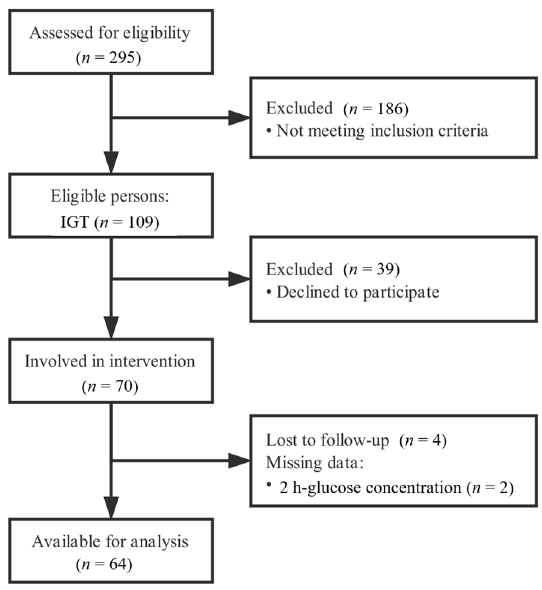
Figure 1. Participant flow diagram.